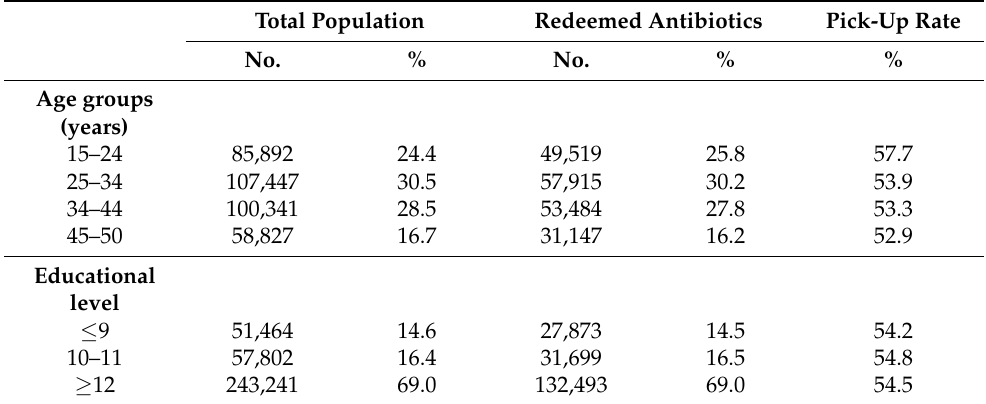
The study population of women with uncomplicated cystitis and the number of antibiotic